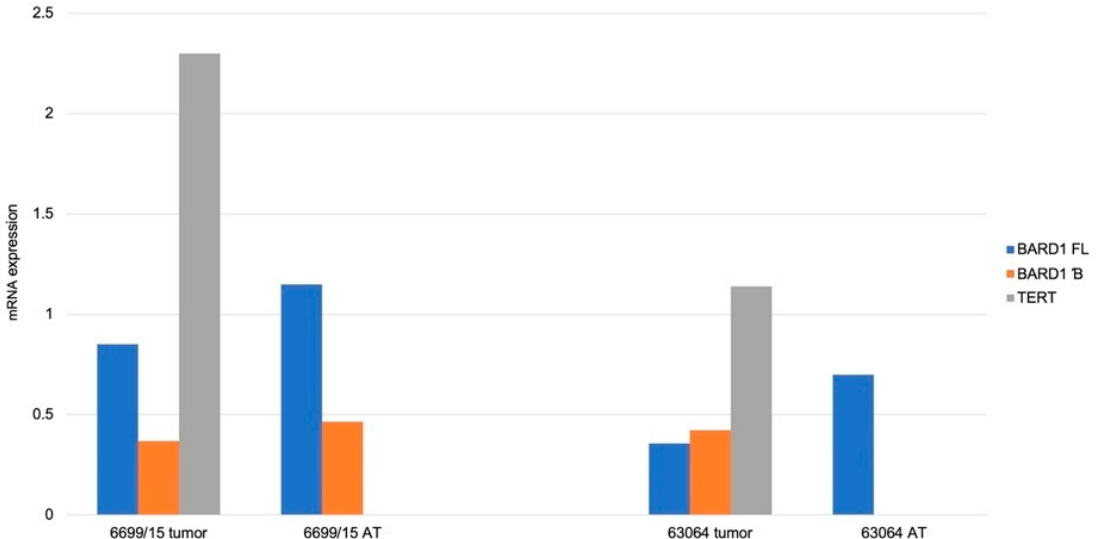
Figure 4. TERT and BARD1 isoforms expression level of yolk sac representative samples. Histogram of mRNA expression